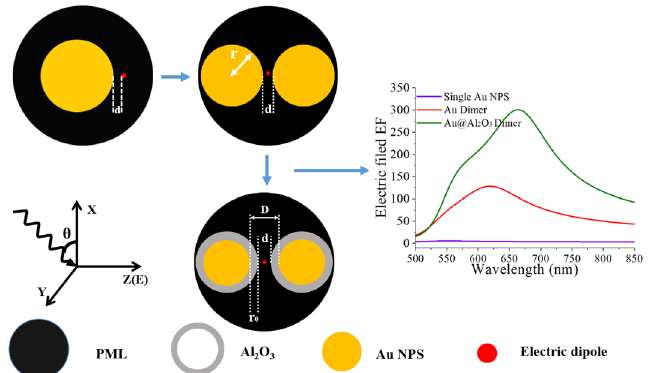
Figure 1. Theoretical model of Au and Au@Al 2 O 3 dimer. On the right is the comparison diagram of the electric field enhancement factors of Au and Au@Al 2 O 3 dimer and a single